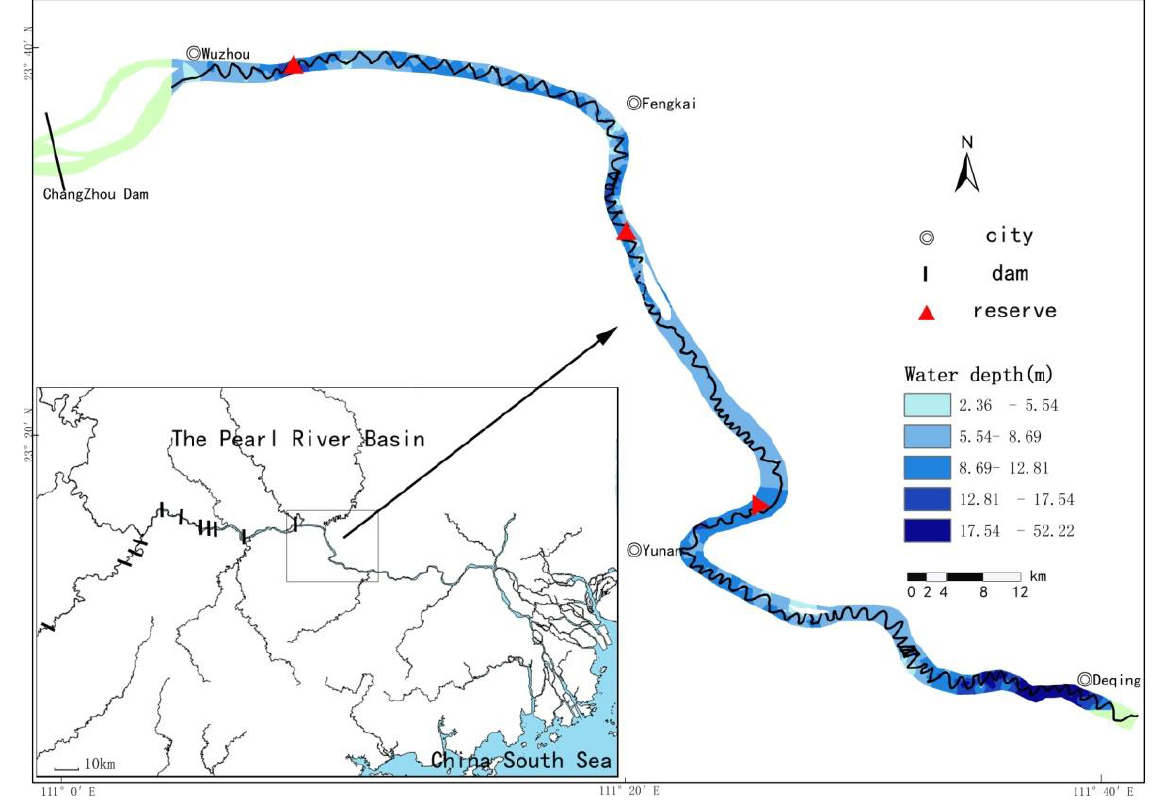
Figure 1. Map showing water depths of the lower Pearl River. The survey transects made with the echo-sounder are indicated by the black line. The red triangles represent the location of fish reserves.